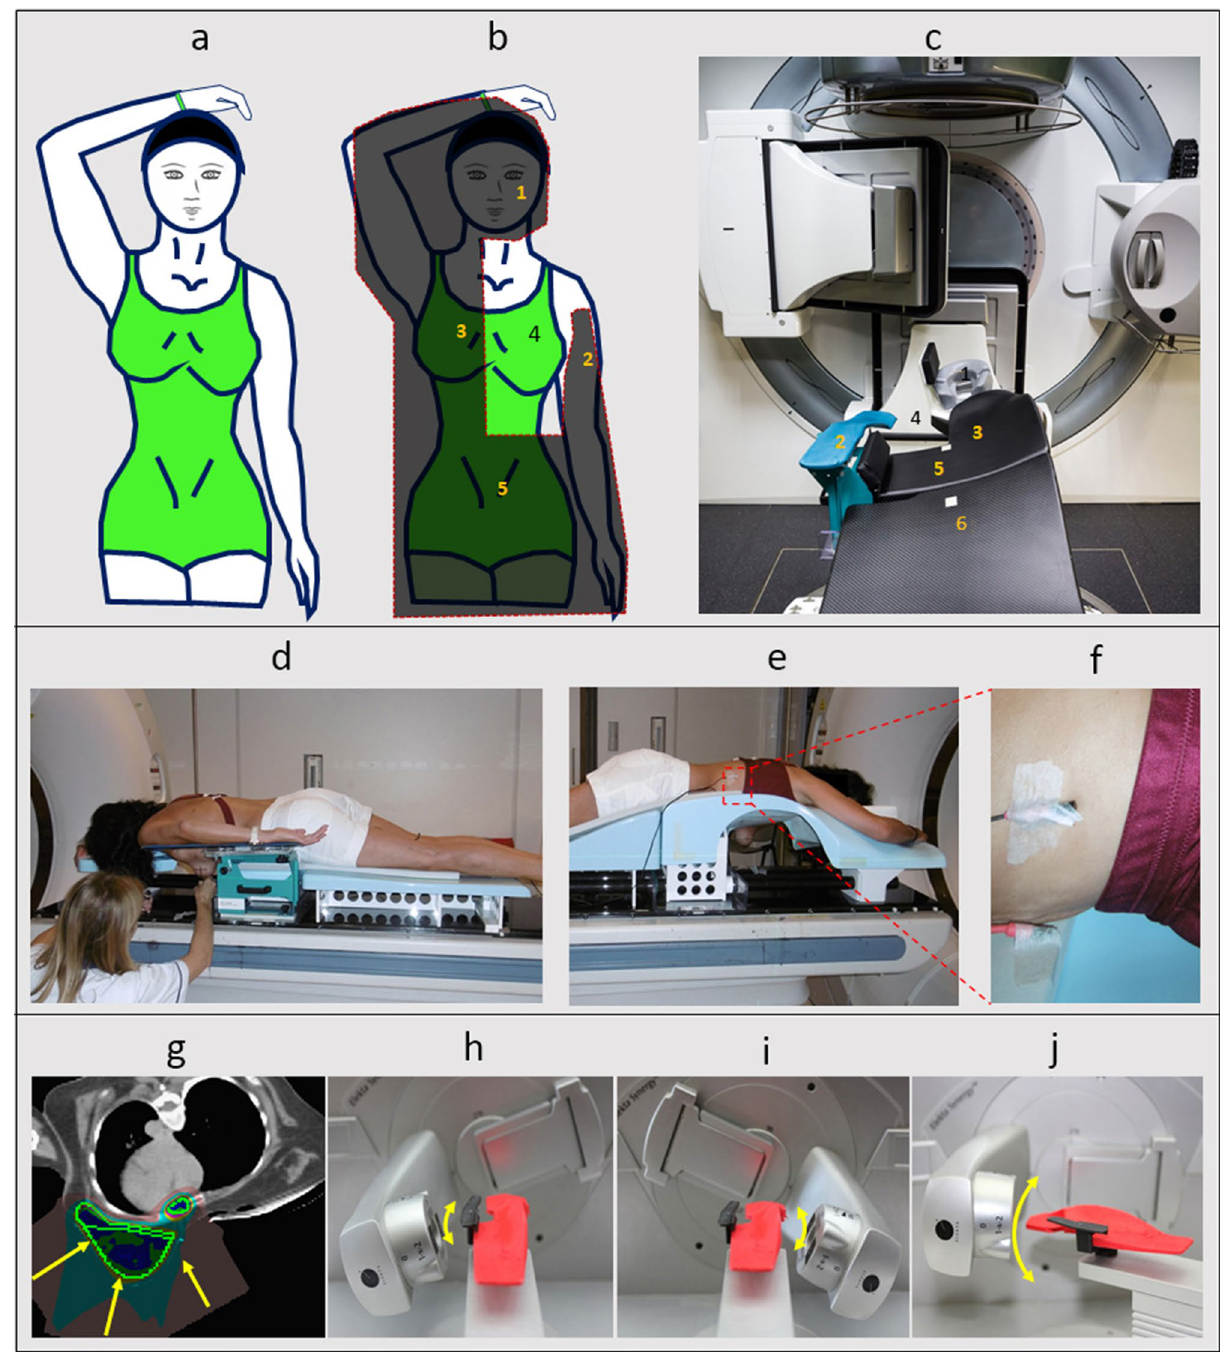
Figure 1. Patient set-up and treatment techniques. (a) Illustration of the prone crawl position for irradiation at the left side. (b) Projection of the support surface of the Prone Crawl Breast Couch. (c) Photograph from above and behind of a Prone Crawl Breast Couch for irradiation at the left side installed on the couch of a linear accelerator. (1. Prone head rest; 2. Arm support blade; 3. Contralateral (untreated) breast support surface; 4. Aperture exposing the ipsilateral (treated) breast and its regional lymph nodes; 5. Lower body support surface and 6. Leg support surface). (d,e) Photograph from the ipsilateral (d) and contralateral (e) sides of a patient positioned for CT-simulation. The ipsilateral breast, lateral thoracic wall and shoulder hardly move with respiration. Therefore, the Respisens sensor system, that monitors the breathing cycle and the DIBH maneuver by real-time registration of the distance between 2 sensors, is placed at the contralateral thoracic wall. (f) Close-up of the sensors. The upper and lower sensors are taped to the lateral thoracic wall of the patient and to an immobile part of the Prone Crawl Breast Couch, respectively. (g) CT-slice in the transverse plane through the mid-breast with arrows indicating the 3 beam directions used in proton therapy plans. (h–j) Model of an Elekta Synergy linear accelerator with scaled 3D-printed Prone Crawl Breast Couch for left side treatment. The arrows give an impression of the arc directions used for photon therapy of the breast and regional lymph nodes. (h) Short arc from the ipsilateral side using 0° couch isocenter rotation. (i) Contralateral short arc